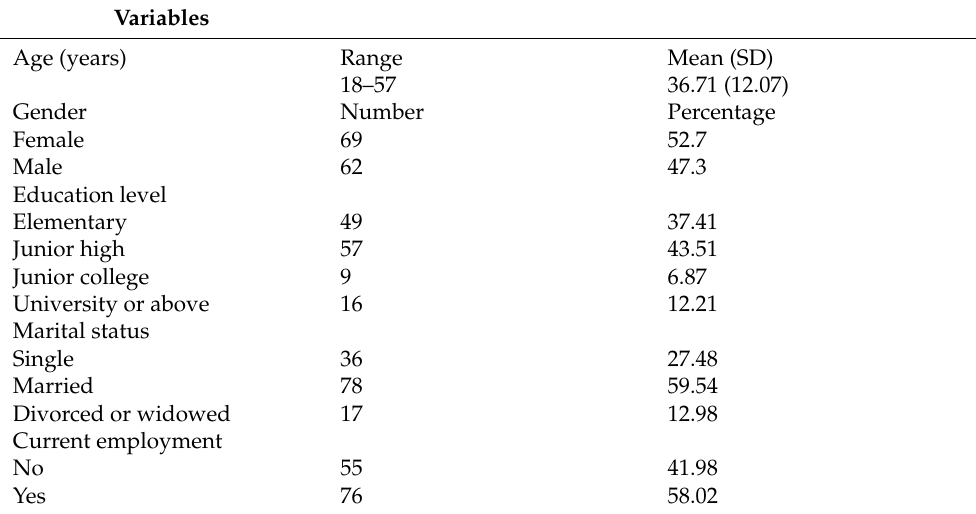
Table 2. Sociodemographic variables of patients ( n =